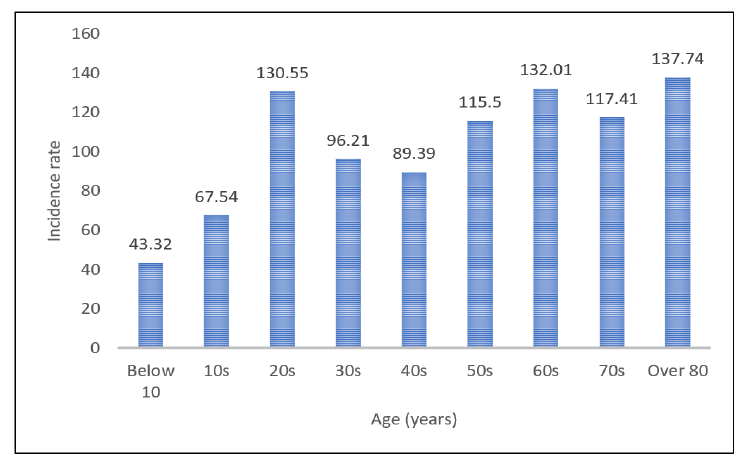
Figure 4. Incidence rate per 100,000 in South Korea as of 24 December 2020.